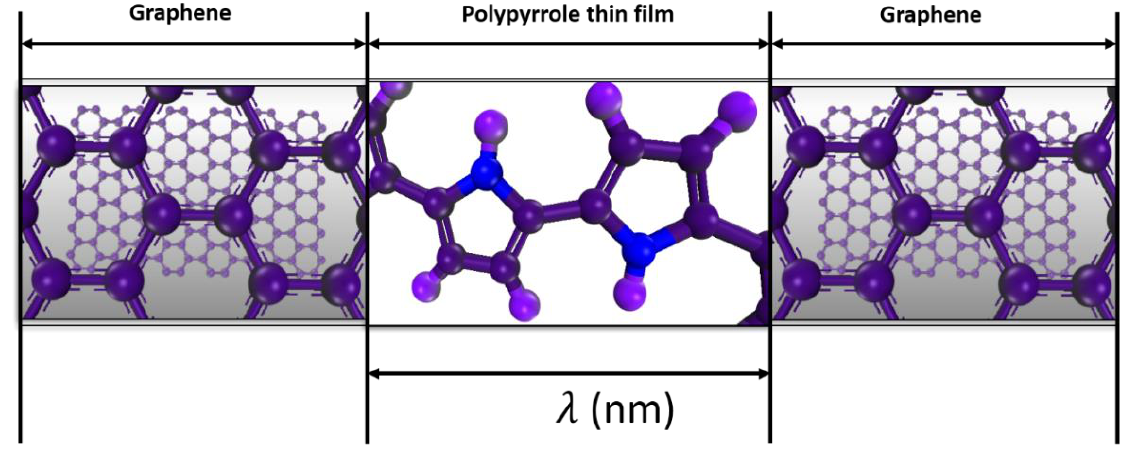
Figure 3. Graphene–PPy composite electrode.